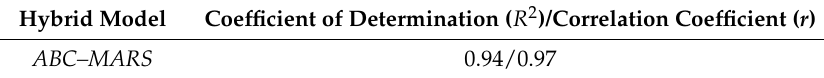
Table 7. Coefficient of determination ( R 2 ) and correlation coefficient for the hybrid ABC-MARS-based model fitted in this